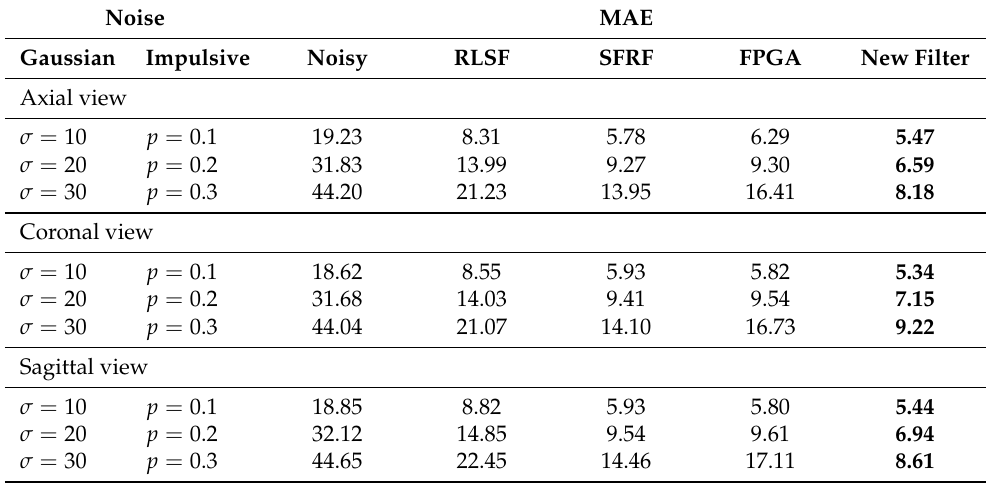
Table 1. MAE measure for noisy and denoised CT images. Values in bold denote the best filtering quality. Noise